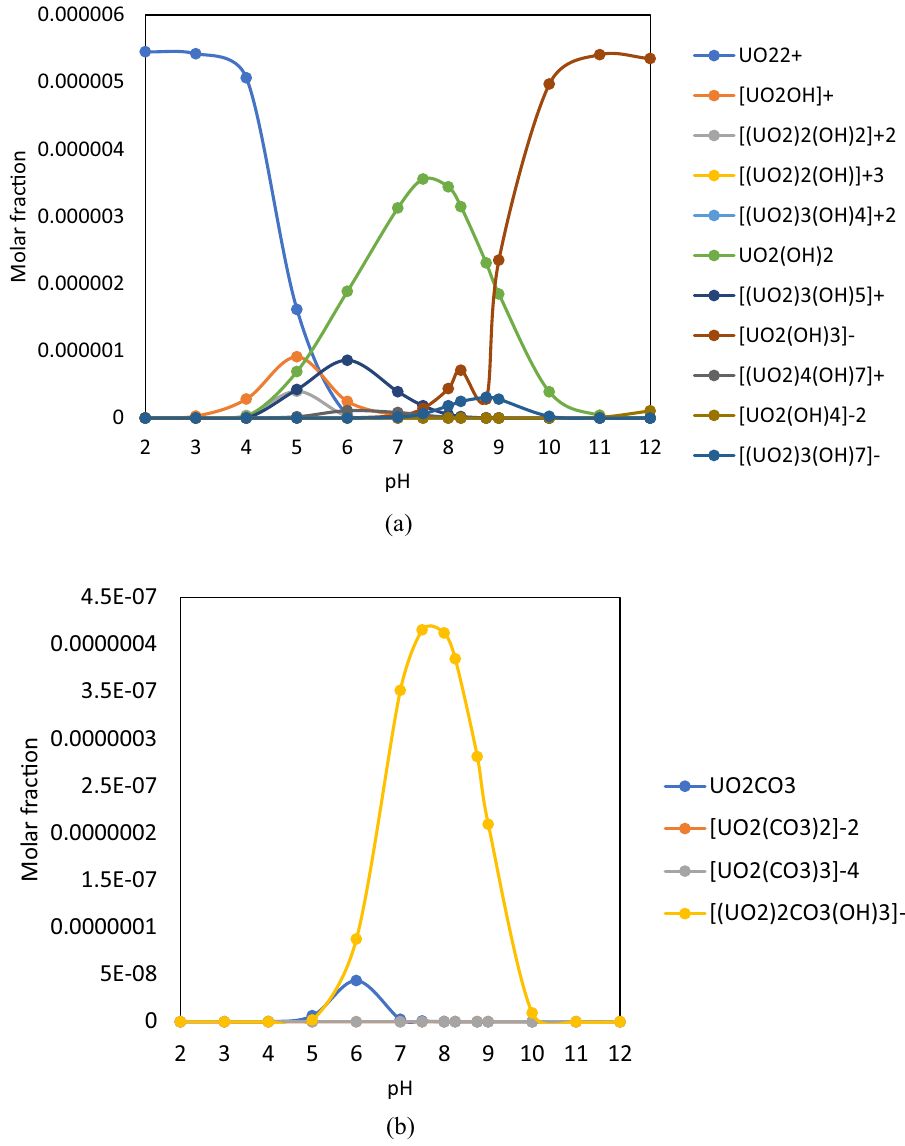
Figure 1. U(VI) species in the mixture U(VI) + Fe(III) calculated by Phreeqc Interactive 3.2.2 software and llnl. dat database. ( a ) hydroxide- complexes; ( b